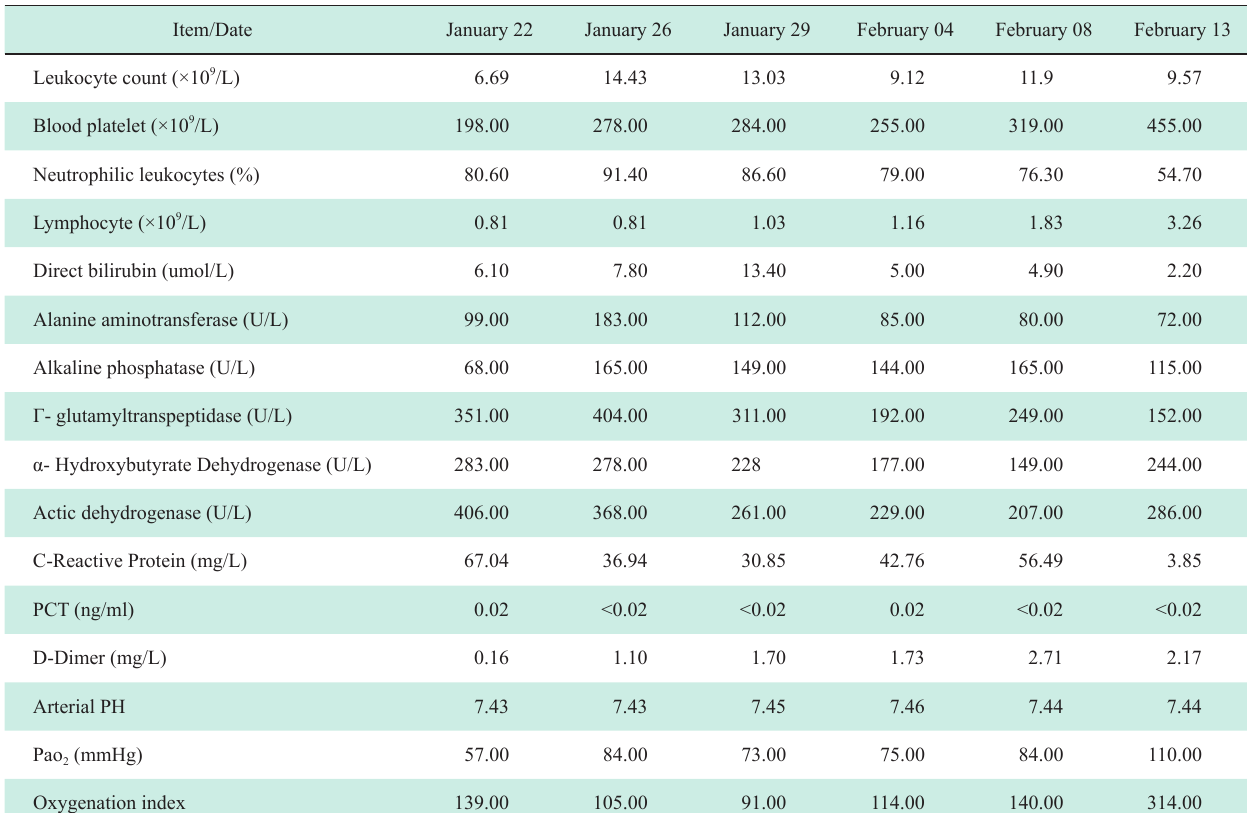
Table 1 Laboratory test